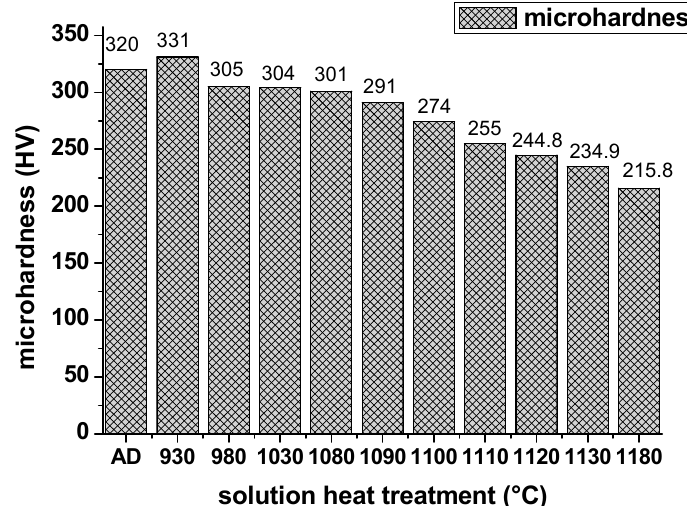
Figure 12. Microhardness of samples under the as-deposited condition and di ff erent solution heat treatment conditions.